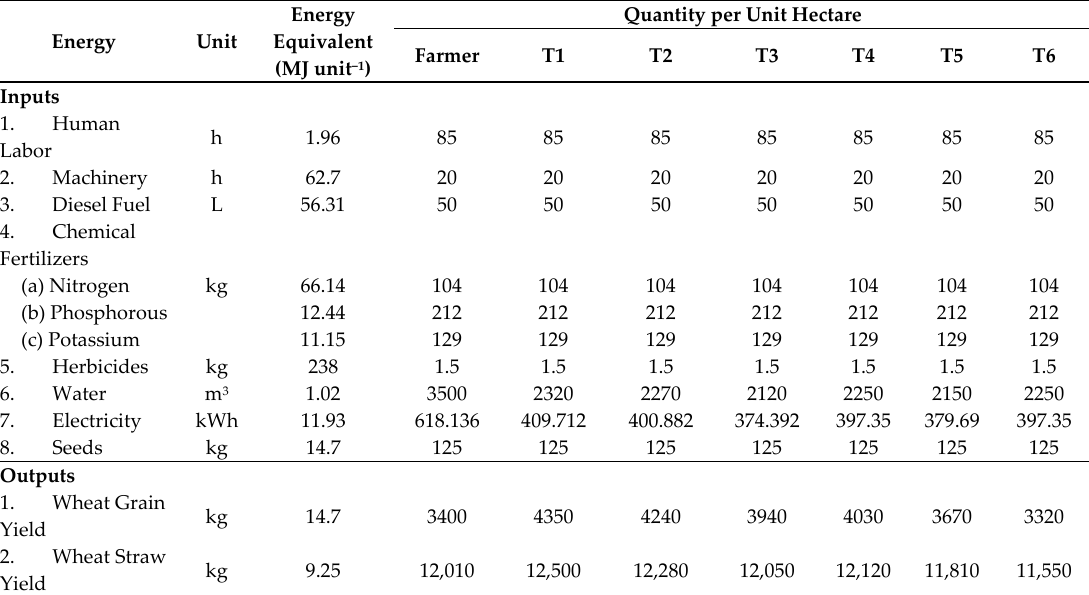
Table 2. Quantity of inputs and outputs per unit hectare in wheat